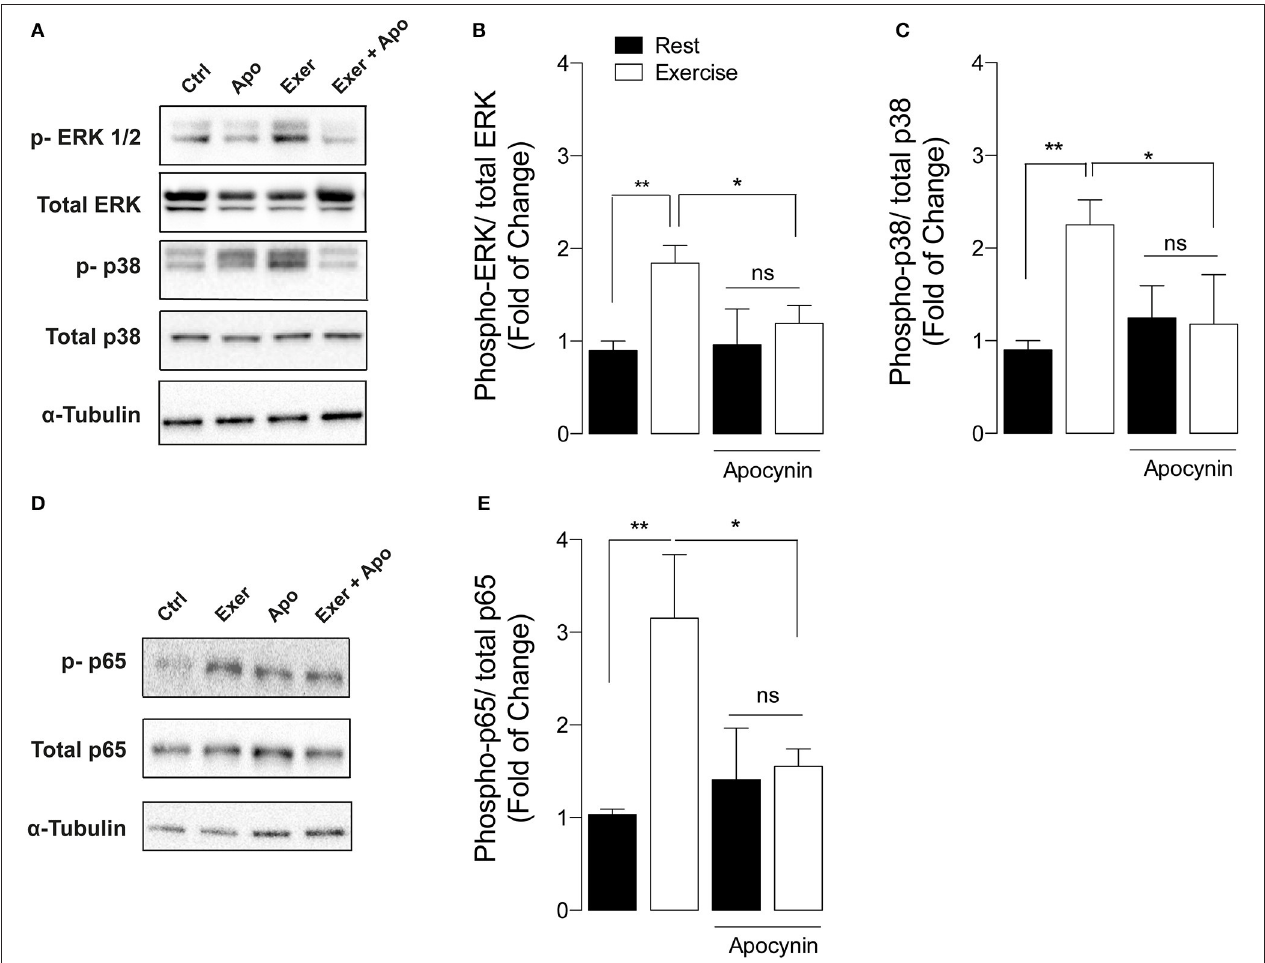
FIGURE 2 | NOX2 inhibition reduces exercise-induced MAPK and NF- κ B activation in skeletal muscle. (A) Representative and (B,C) quantification of western blot showing ERK ½ , and p38 phosphorylation after exercise in both apocynin and vehicle-treated mice. (D) Representative blot and (E) quantification of p-p65 NF- κ B levels from both apocynin and vehicle-treated mice. Data are expressed as mean ± SD from five different determinations. * p < 0.05 , ** p < 0.01 ; and ns, no significant difference, one-way ANOVA-